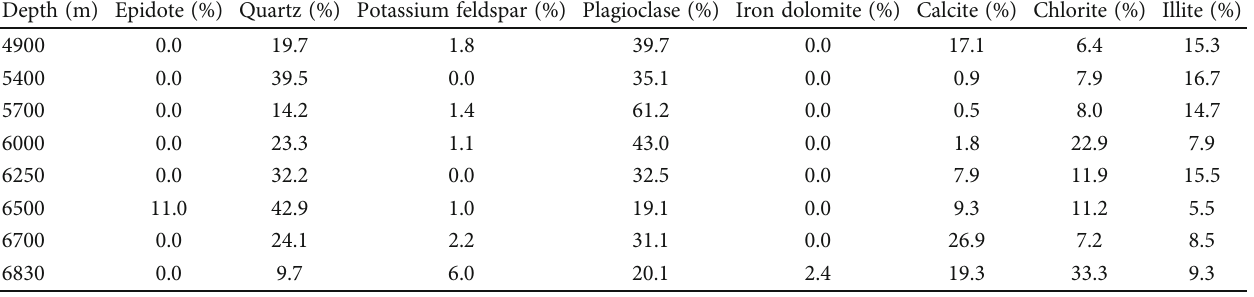
Table 1: Mineral composition and relative mass content of rocks at di ff erent depths.